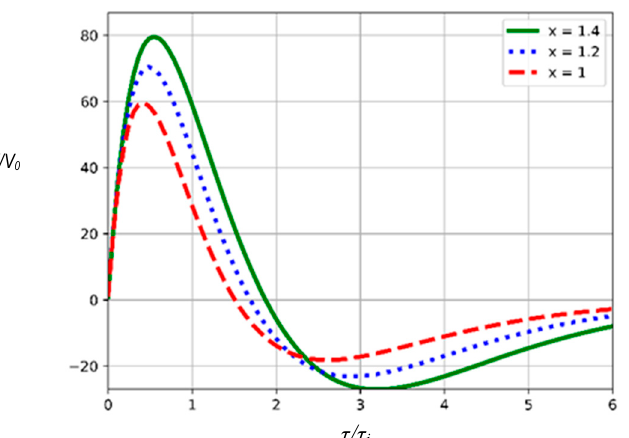
Figure 3. The dependence of v / v 0 as a function of τ / τ i for the different values of dimensionless radius 𝓍 .